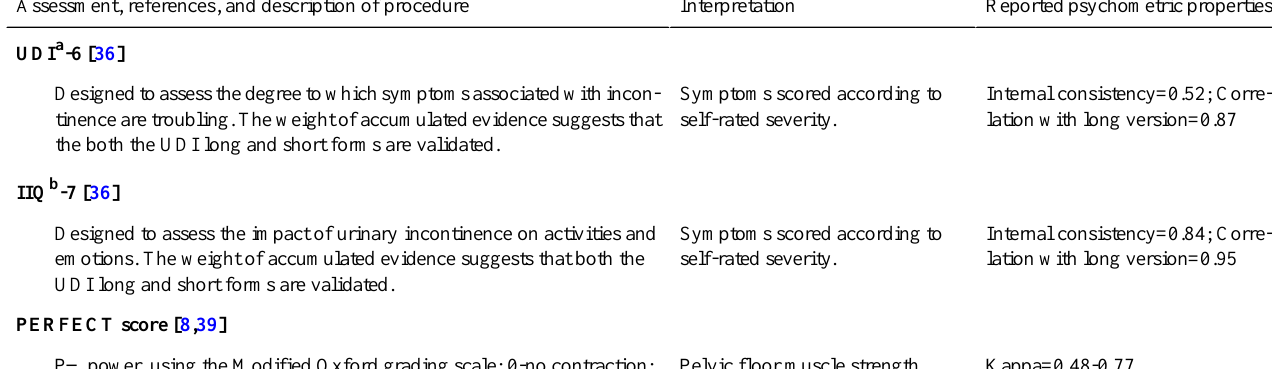
Reported psychometric propertiesInterpretationAssessment, references, and description of procedure